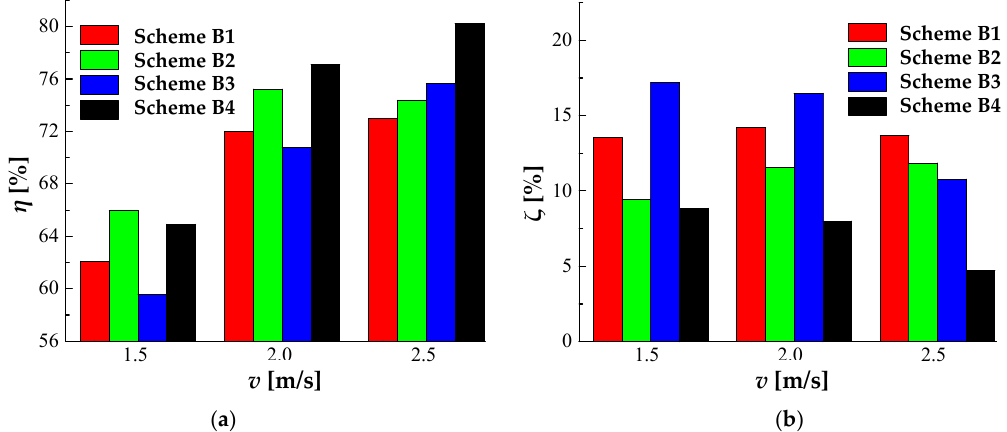
Figure 8. Efficiency and draft tube hydraulic loss of different turbine with different velocity. ( a ) The overall efficiency of the four schemes; ( b ) the hydraulic losses in draft tubes of the four schemes.